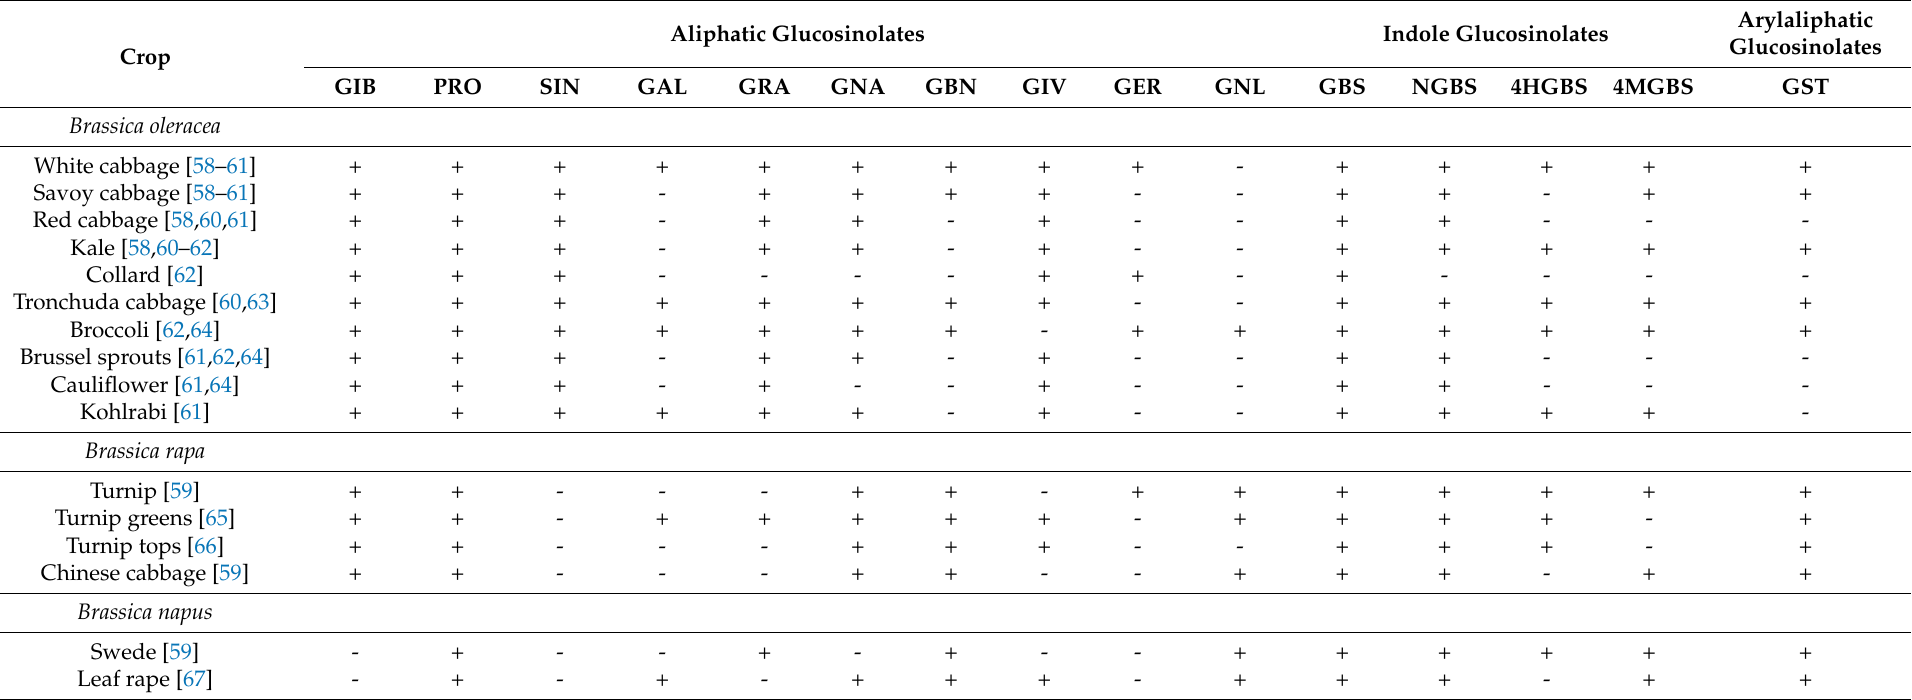
Table 2. Principal glucosinolates identified in leaves of Brassica vegetable